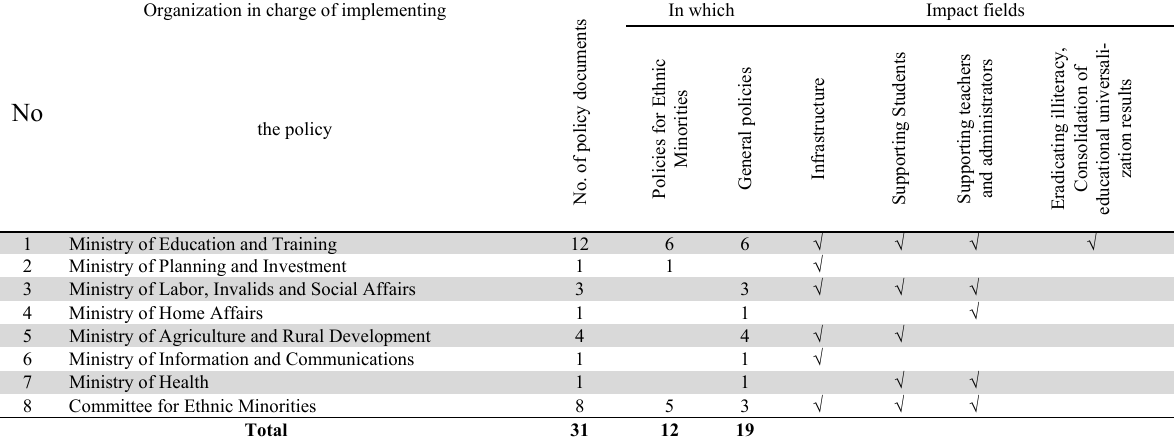
Central level policy documents issued on ensuring basic education for ethnic minorities valid in 2019 Organization in charge of implementing In